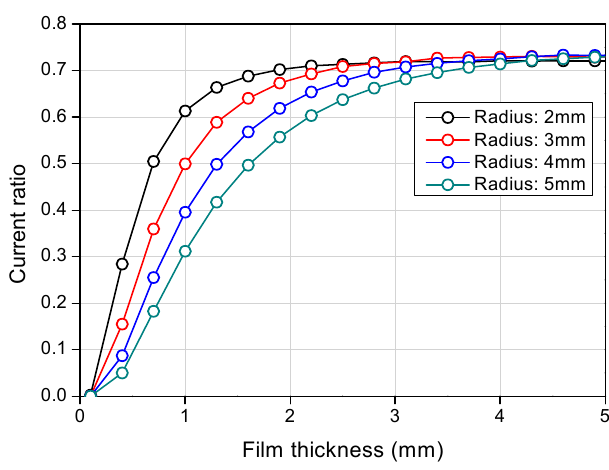
Figure 6. Electrical potential field calculation result according to the radius size.